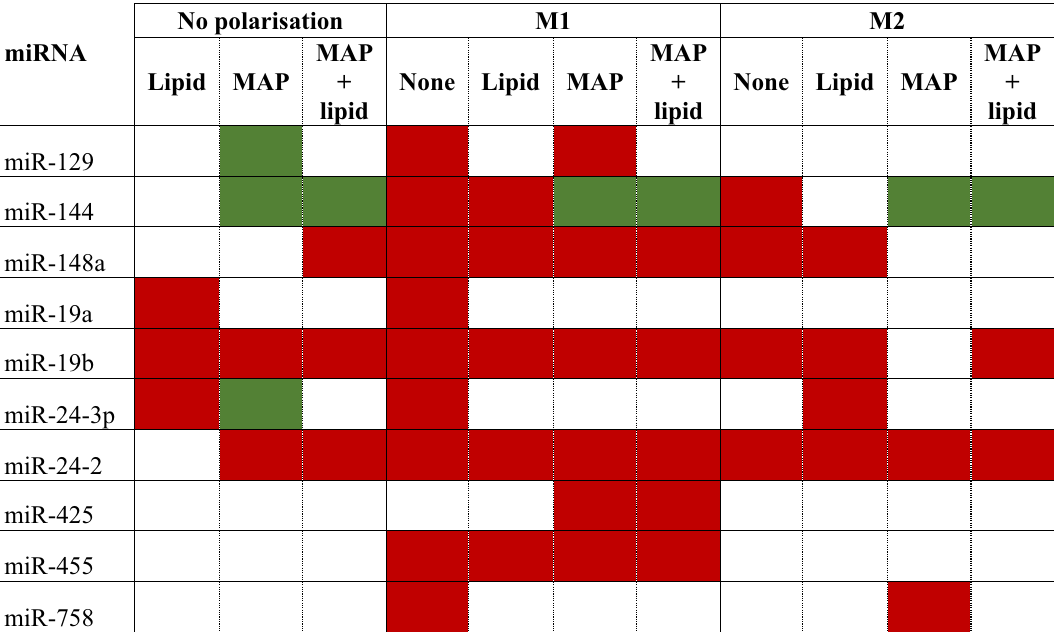
Table 2. Change in miRNA expression in MAP infected murine macrophages. Red boxes indicate upregulated miRNA and green boxes represent downregulated miRNA compared to control uninfected cells. While boxes indicate no significant differential expression. Log2 fold changes ± 1.5 compared to control uninfected cells was considered differentially